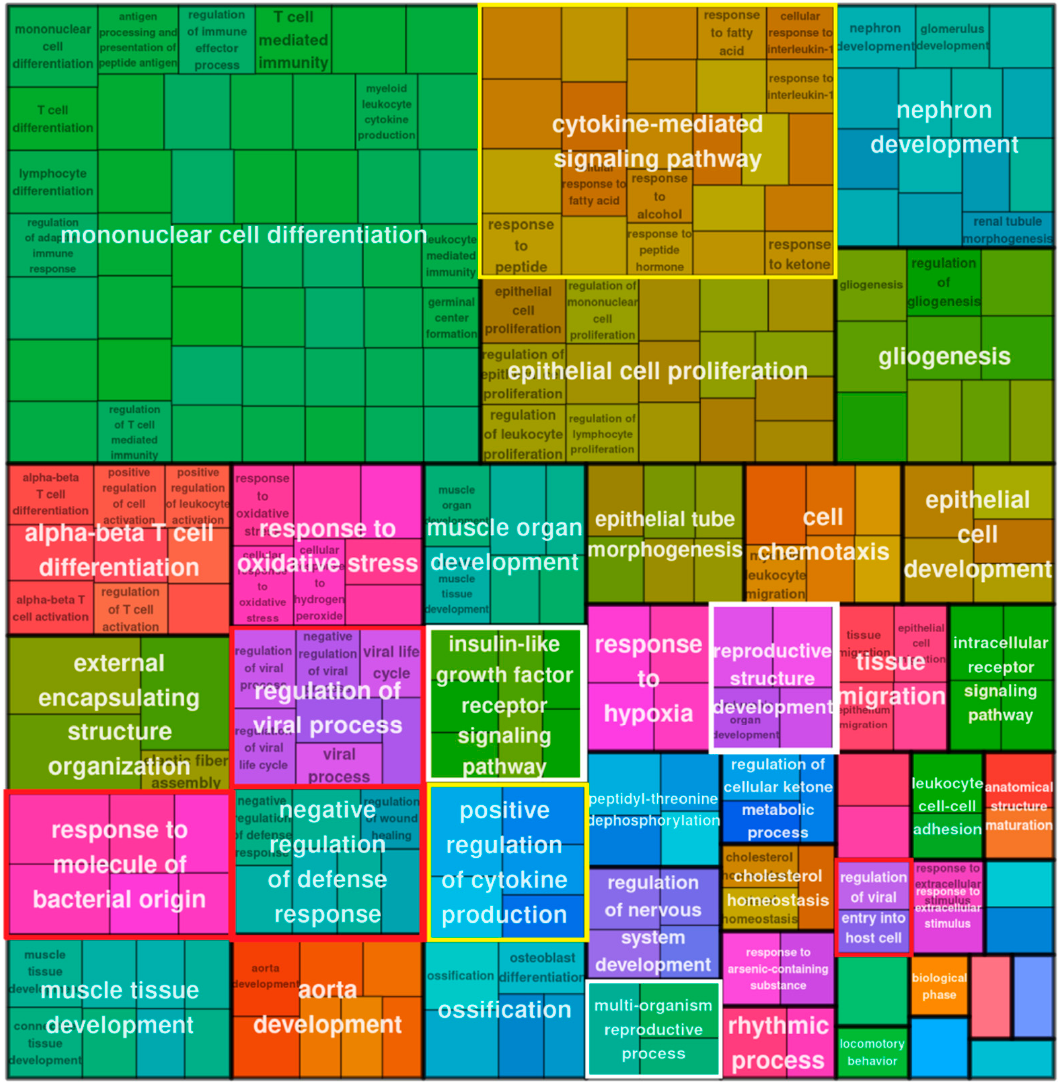
Figure 3. Treemap plot representation of the Gene Ontology Biological Process (GO BP) enrichment analysis (GO modules with hypergeometric test pAdj < 0.05 classed as enriched) for bivalent genes upregulated in MDA-MB-231 cells on day 5 post-DOX.